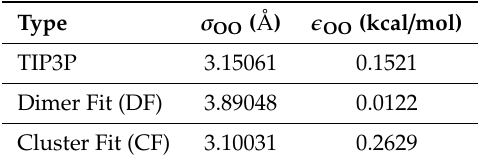
Table 1. The two sets of QM / MM LJ parameters generated in this work, compared to the TIP3P LJ parameters. See Section 4.1 for their